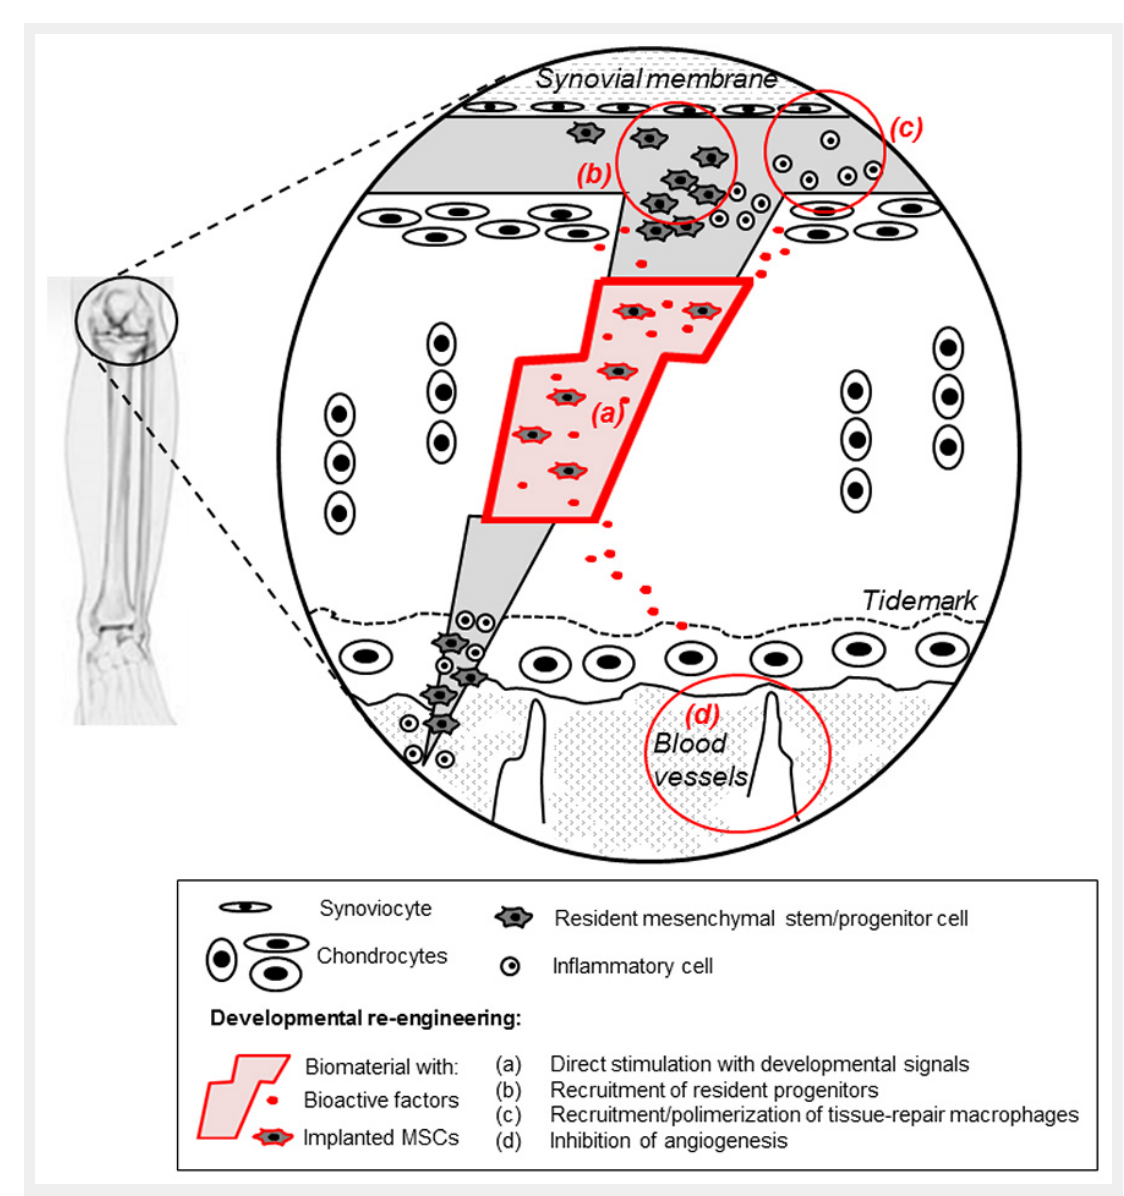
Developmental re-engineering strategy for cartilage repair. We envision the implantation of a graft fitting the site of the injury and able to integrate and release in a spatiotemporally controlled manner either one or several bioactive factors among: (a) developmentally inspired signals to guide either implanted or (b) resident progenitor cells towards a chondrogenic phenotype, (c) factors for the recruitment and polarisation of tissue-repair macrophages or (d) anti-angiogenic factors. MSC = mesenchymal stromal/stem